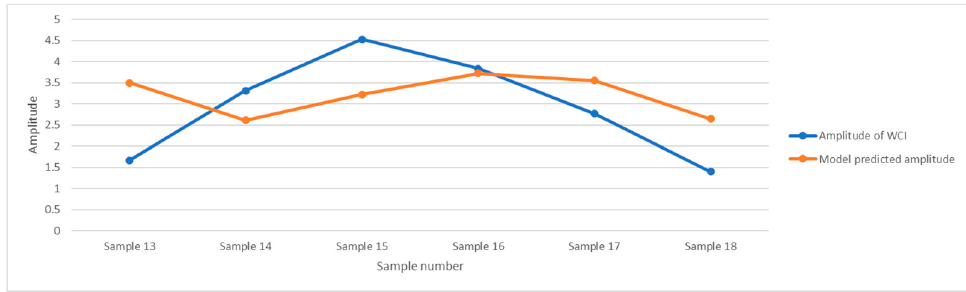
Figure 6. Regression model validation of WCI amplitude obtained by estimating the other 6 samples.